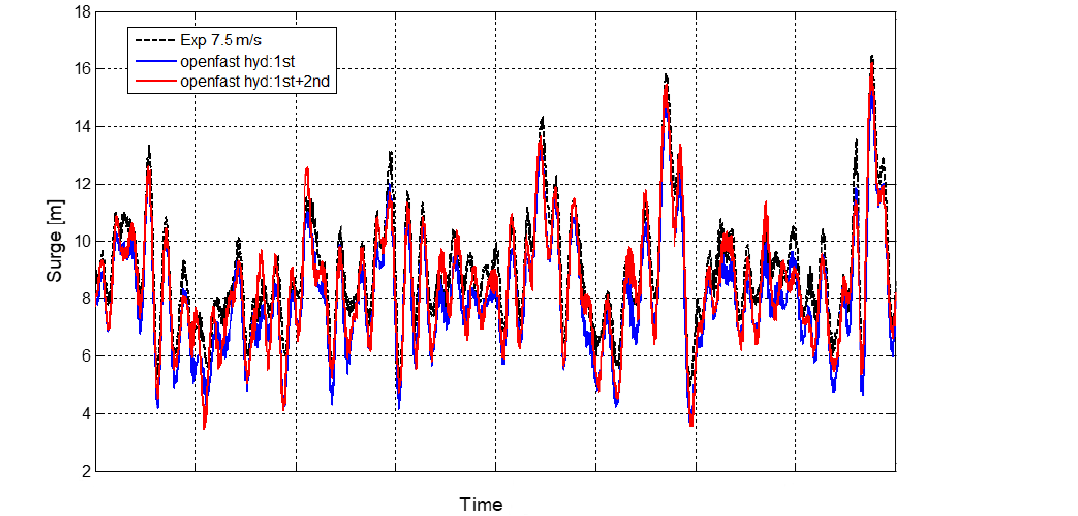
Figure 9. Time series for platform surge response under 7.5ms − 1 turbulent mean wind speed and irregular waves with H s = 2 . 0m and T p = 8 . 5s.